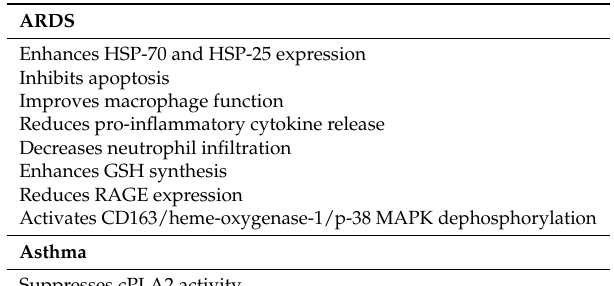
Table 2. Regulatory mechanisms of glutamine in respiratory